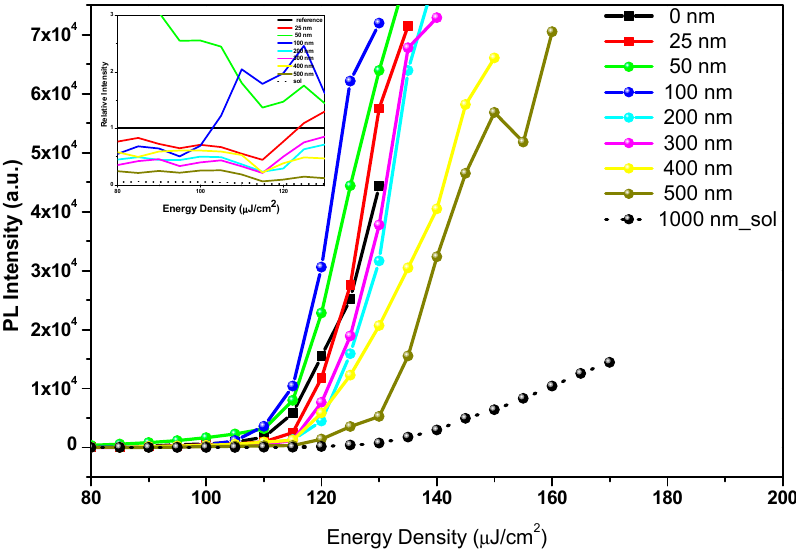
Figure 9. Photoluminescence (PL) intensity versus the energy density of CsPb(Br 0.5 Cl 0.5 ) 3 thin films, bare and with various thicknesses of polymethyl methacrylate (PMMA) as a passivation layer. The inset figure shows the relative intensity of various thicknesses of the passivation layer to bare film for t = 0, which is used as a reference for the energy